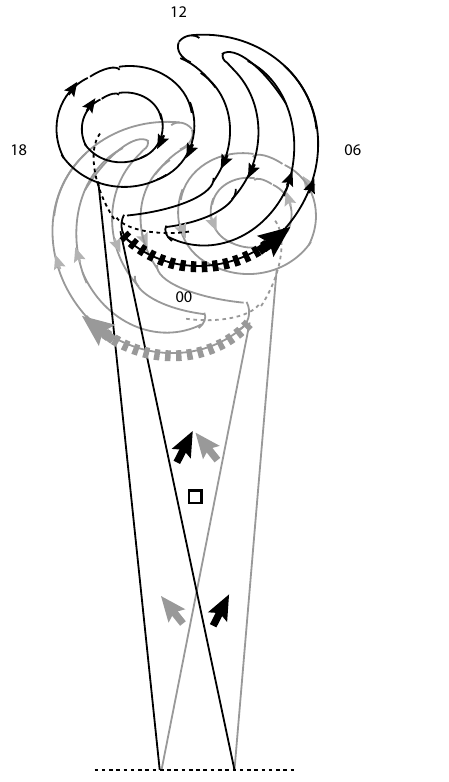
Figure 2. Schematic illustration of the untwisting of positively twisted tail field lines when looking down from the north. The dotted lines indicate the reconnection line in the nightside iono- sphere and in the magnetotail. The solid arrowed curves show the ionospheric convection streamlines and the thick dashed arrows de- pict the azimuthal flow bursts associated with the untwisting. The straight lines represent field lines, which connect the two hemi- spheres via the reconnection line. The short solid arrows indicate the directions of convective magnetotail fast flows associated with the untwisting. For clarity, the Northern and Southern Hemispheres are coloured by black and grey, respectively, and the ionospheric convection patterns are slightly separated. The black square marks a satellite position in the region where an azimuthal flow shear with a reversal generated by the untwisting field lines can be observed if the satellite is moving in the north–south direction across the neutral sheet (after Grocott et al., 2005).